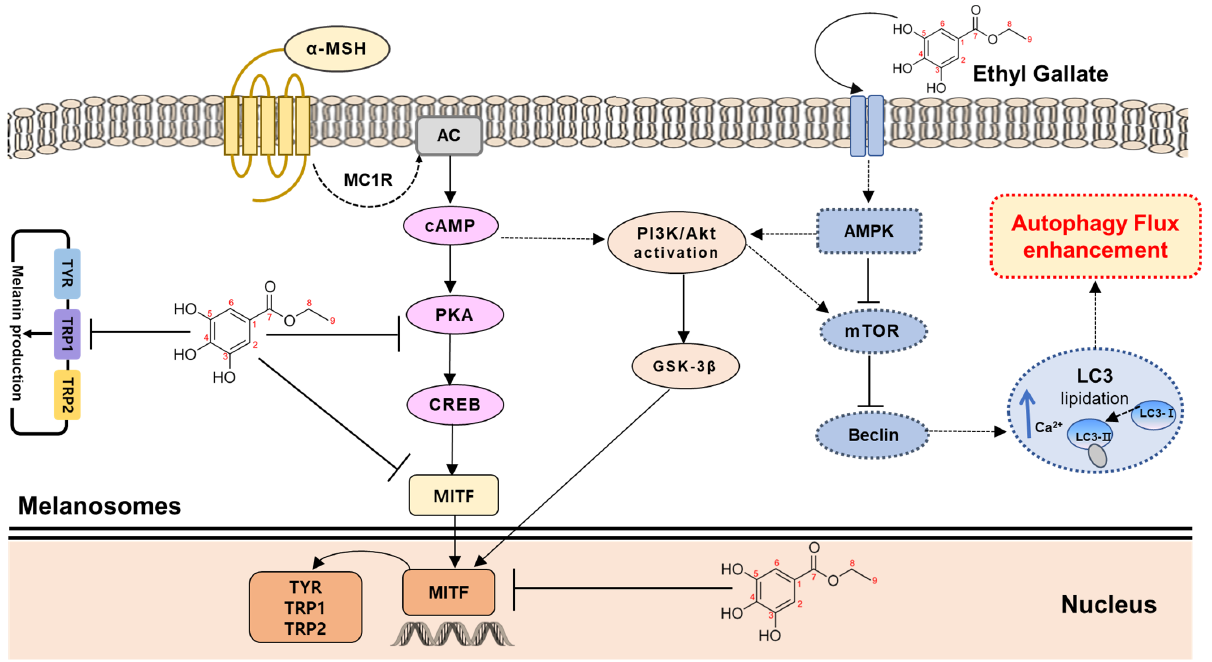
Figure 13. Schematic diagram of the signaling pathway of antimelanogenesis–autophagy